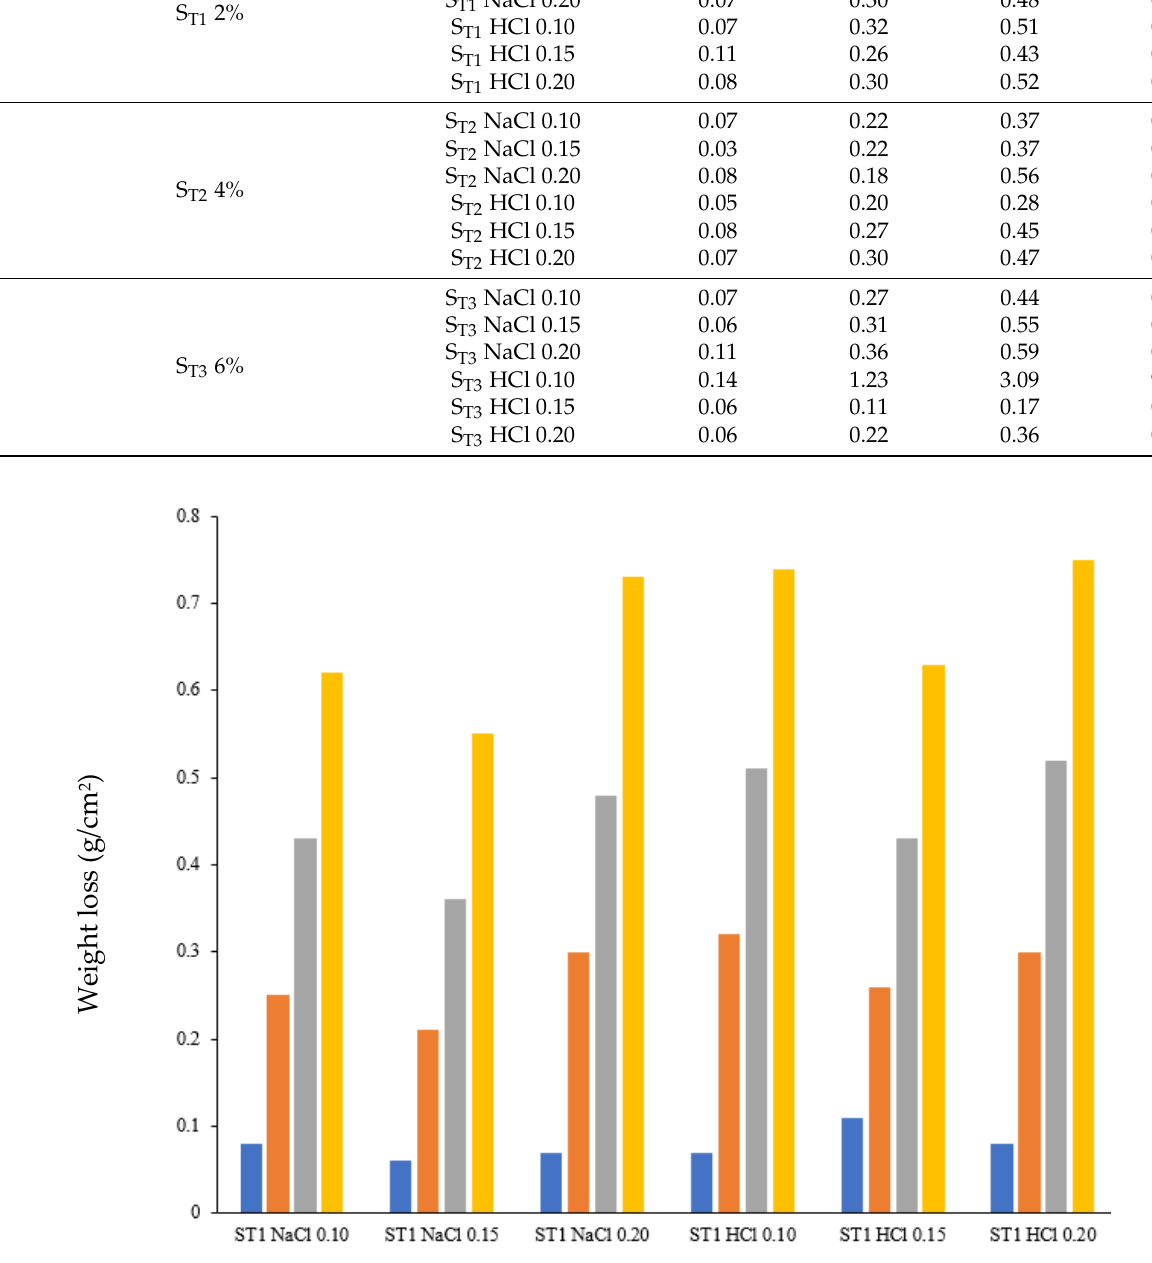
Figure 7. Effect of heat treatment on corrosion behaviour of S T1 (2%).